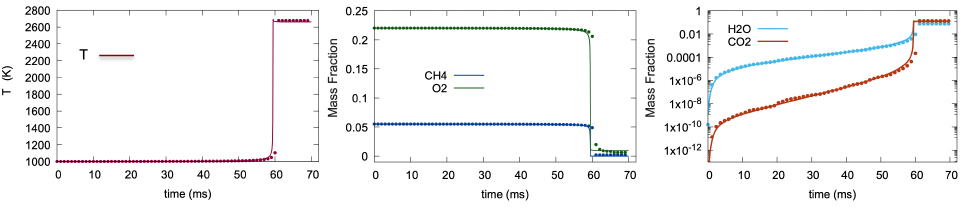
Figure 9. Temporal variation of temperature and species mass fraction. Solid line and symbols represent the OpenFOAM and LIT solutions